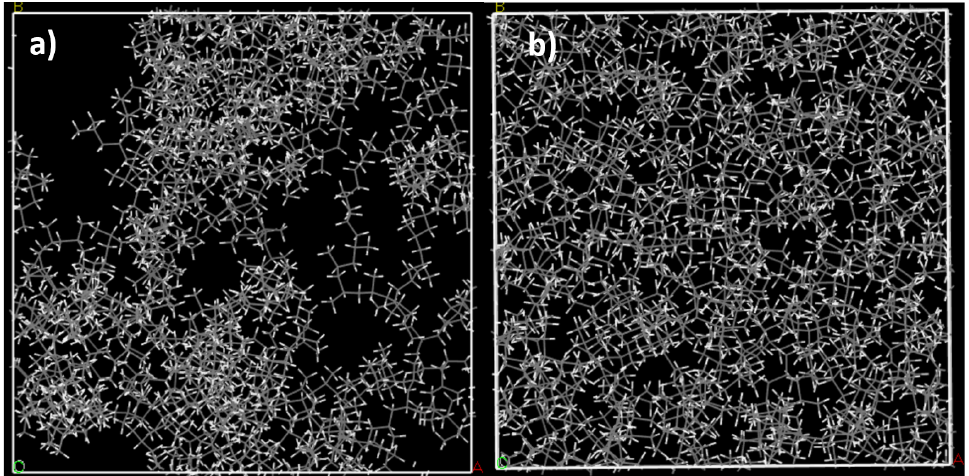
Figure 3. ( a ) Initial model of the amorphous syndiotactic PP containing 10 chains of 50 monomers (box dimension 4.12 nm, density approx. 0.5 g/cm 3 ). ( b ) Final model after geometry optimization and annealing cycles (box dimension: 3.46 nm, density approximately 0.84 g/cm 3 ).